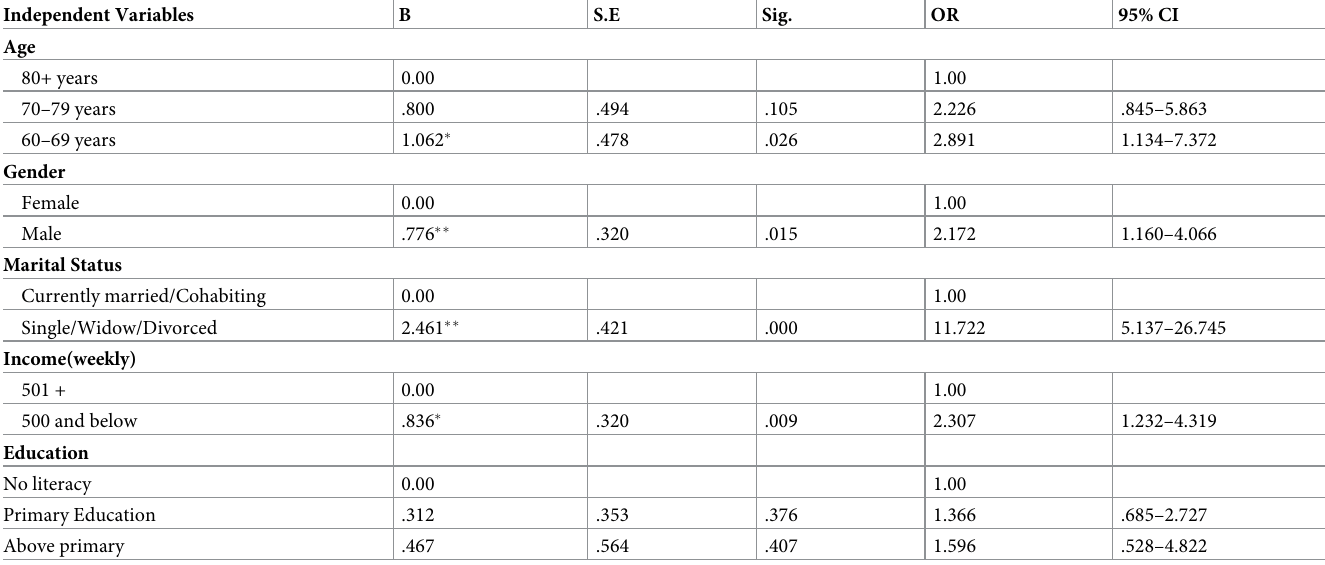
Table 2. The results of multiple logistic regression analysis on predicting persons suffering from chronic disease based on age, gender, marital status, income, and education. Independent Variables B S.E Sig. OR 95%